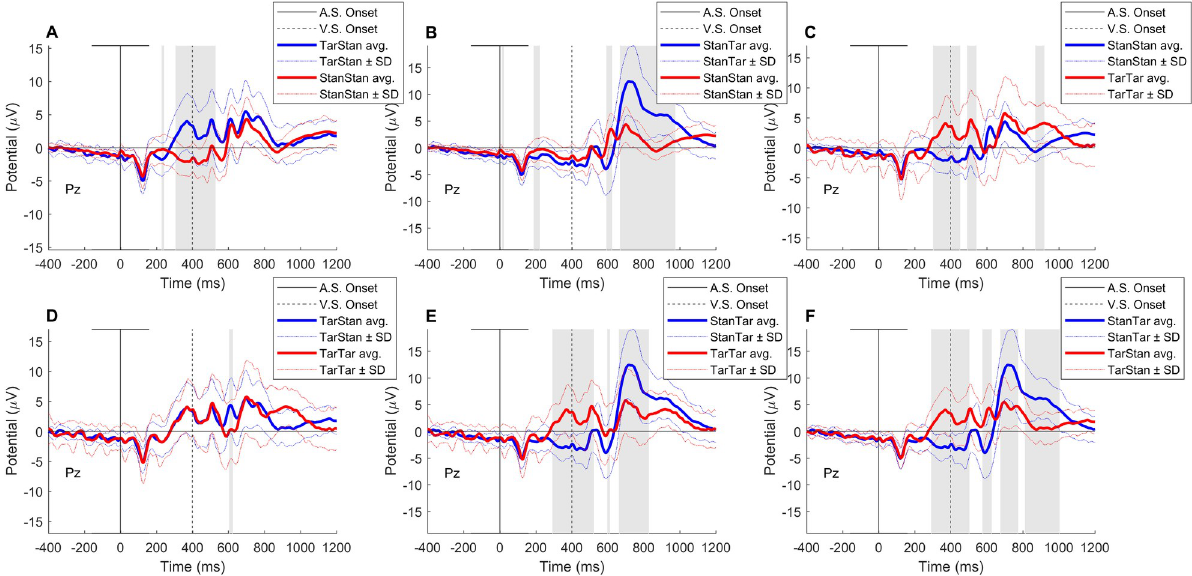
Fig 2. Exploratory one-to-one comparison of grand average event-related potential waves between conditions using the paired t -test with correction for the false discovery rate. The highlighted areas correspond to an amplitude difference with a p-value < 0.001. The solid black line indicates the onset of the auditory stimuli (AS) and the black dashed line shows the onset of the visual stimuli (VS). (A) Comparison of standard- standard and target-standard conditions revealed a significant difference between amplitudes in the time range of 308–528 ms containing two peaks. The first peak corresponds to the auditory P300 and the second peak to the visual P100. (B) Comparison of standard-standard and standard-target conditions showed a major significant difference between amplitudes in the time range of 670–975 ms, which corresponds to the time course of the visual P300. (C) Comparison of the standard-standard and target-target conditions revealed major significant differences in amplitude in the range of 303–450 ms, corresponding to the auditory P300 and in the range of 493–540 ms, which corresponds to the visual P100. However, no major difference in amplitude was detected in the time range of the visual P300, which suggests that the visual P300 has been suppressed. (D) Comparison of the target- standard and target-target conditions did not show any major differences in amplitude between the two conditions. This includes the time range of the visual P300, suggesting that the visual P300 has been suppressed under the target-target condition. (E) Comparison of the standard-target and target-target conditions indicates significant differences in amplitude in the range of 295–520 ms with two peaks corresponding to the auditory P300 and the visual P100, respectively. Moreover, the differences in amplitude in the time range of 665–828 ms, which corresponds to the time course of the visual P300, were flagged as significant, indicating that the visual P300 amplitude was suppressed under the target-target condition. (F) Comparison of the standard-target and target-standard conditions revealed significant differences in amplitude in the time range of 291–501 ms with two peaks corresponding to the auditory P300 and the visual P100. Moreover, differences in amplitude in the approximate time range of 676–1002 ms, corresponding to the visual P300, were significant. Panels C, D, and, in particular, panel E indicate suppression of the visual P300 following the auditory P300. Panels A, C, E, and F indicate enhancement of the amplitude of the visual P100 following the auditory P300. This figure also